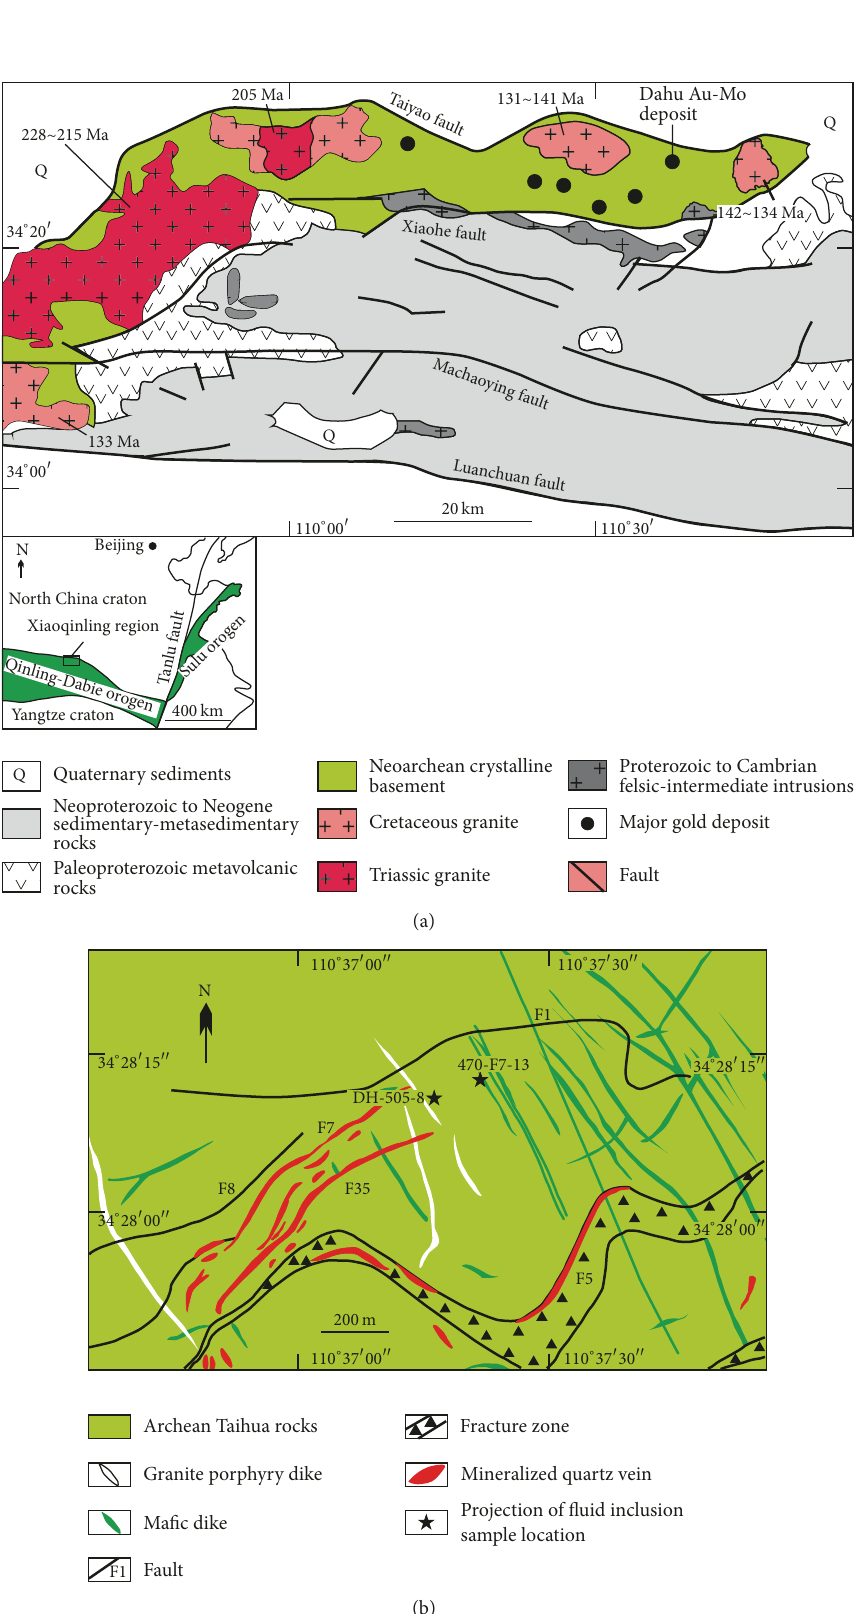
Figure 1: (a) Geologic map of the Xiaoqinling region and its position in China (after [22]). (b) Geologic map of the Dahu Au-Mo deposit (modified from